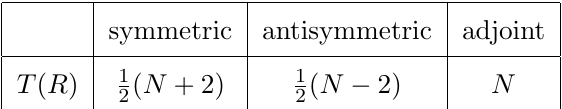
Table 1 . Index for SU( N ) rank-two and adjoint representations. (Since the adjoint representation is real, one could also take the corresponding fermion to be a Majorana fermion | that model was discussed in detail in